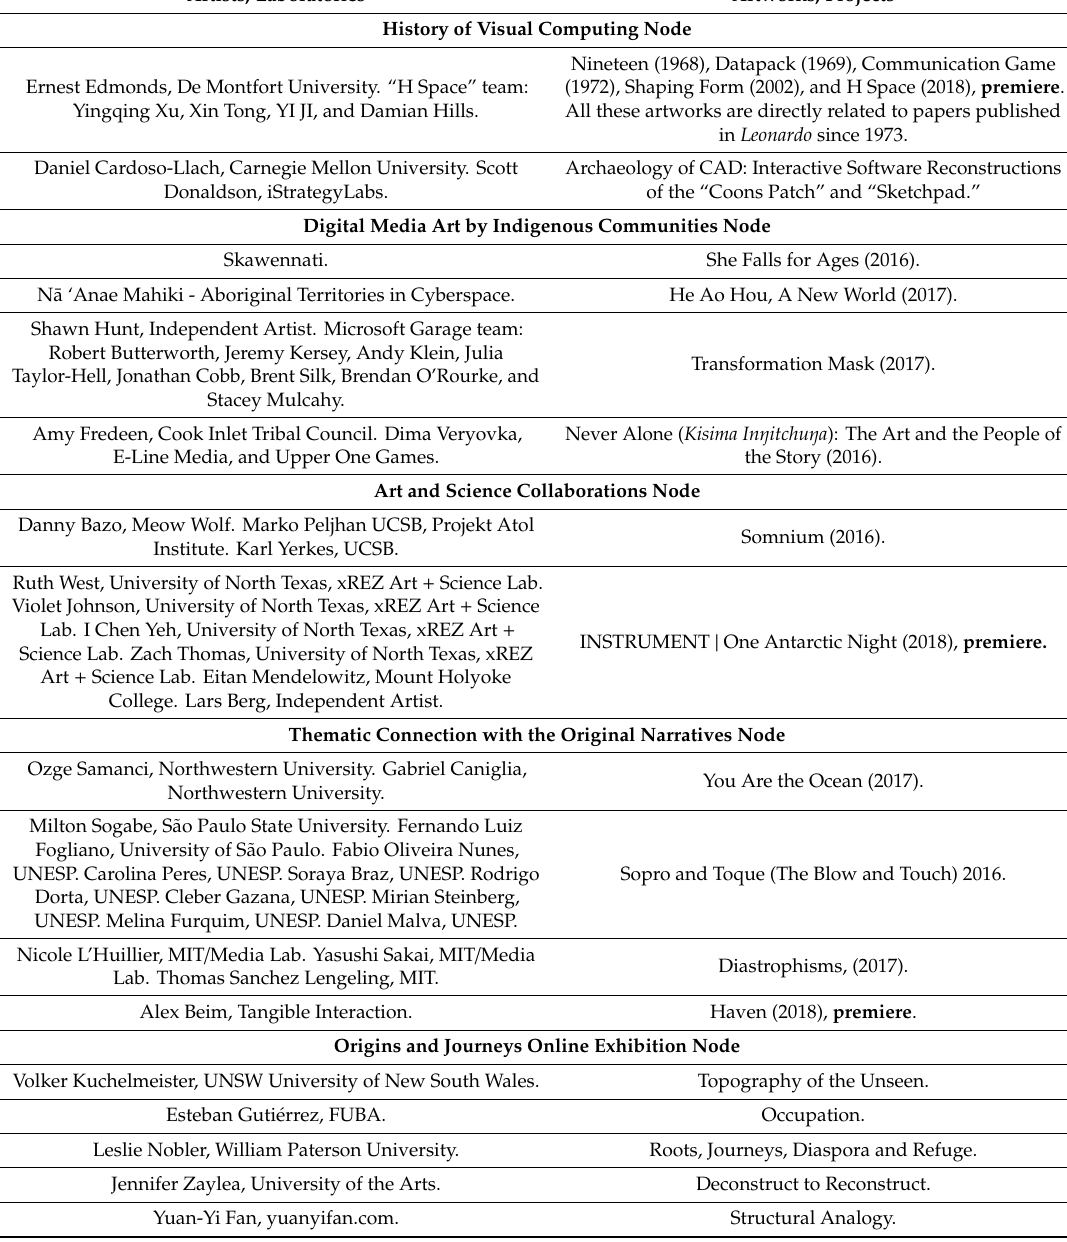
Table A1. Complete list of artists, artworks and projects that participated in the SIGGRAPH 2018 Art Gallery curated by